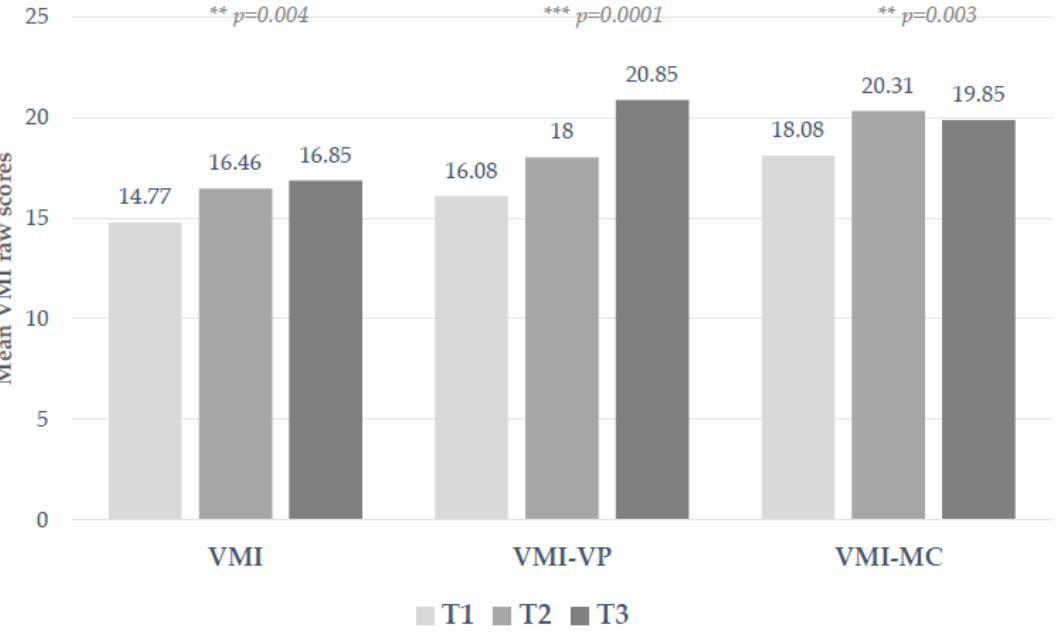
Figure 1. Mean differences in children’s visual-motor integration performance scores (VMI), discrimination abilities (VMI-VP), and motor coordination (VMI-MC), measured at baseline (T1), after